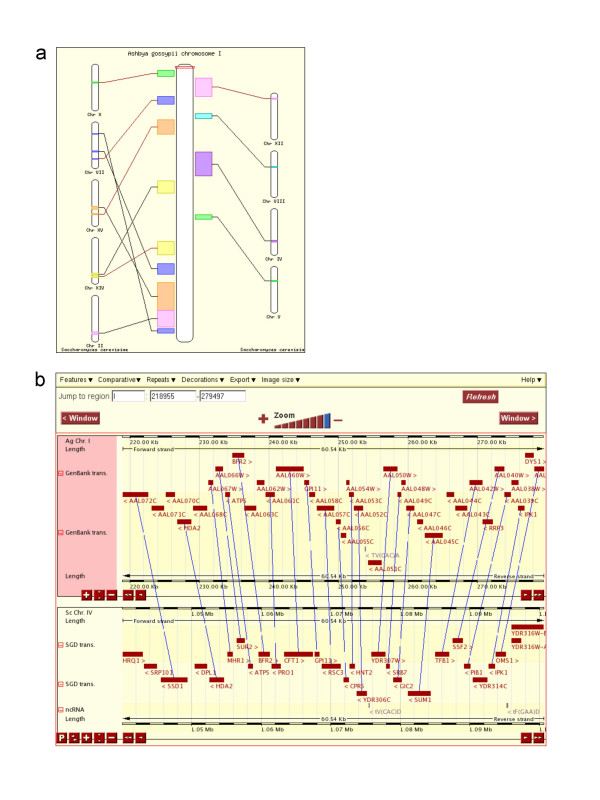
The synteny viewer. Panel a displays syntenic chromosomal regions from A. gossypii and S. cerevisiae. Panel b shows different levels of the MultiContigView as indicated where homologous genes in a given region are connected with lines.